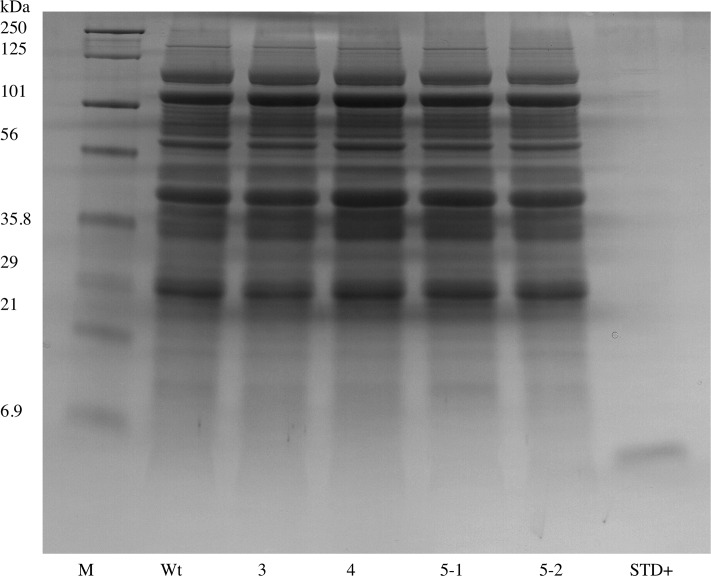
Analysis of total soluble protein by one-dimensional gel electrophoresis of hEGF expressing transgenic soybean seeds.Proteins from 3 independent homozygous EGF transgenic soybean lines (3, 4, 5) were extracted and compared to seed extracts from nontransgenic (Wt) and commercially available hEGF standard (STD+). M marker, kDa kilobases.